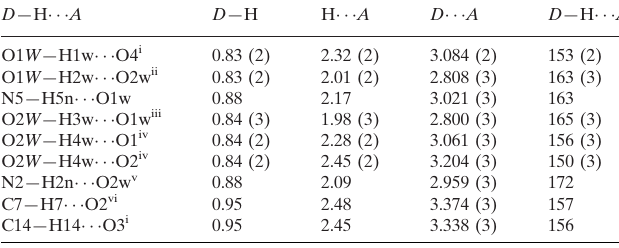
Hydrogen-bond geometry (A˚ , (cid:3)